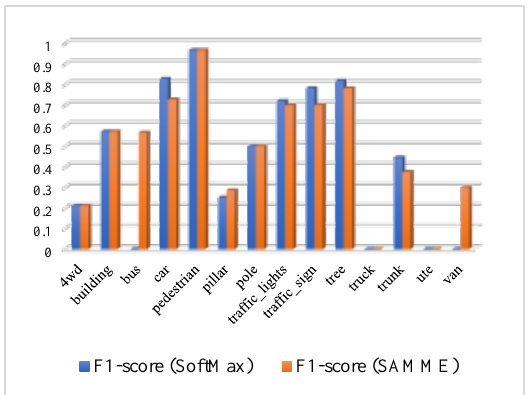
Figure 8. The F1-score of SoftMax and SAMME algorithms on feature instances extracted from the fully connected layer of the trained Vox-Net model.